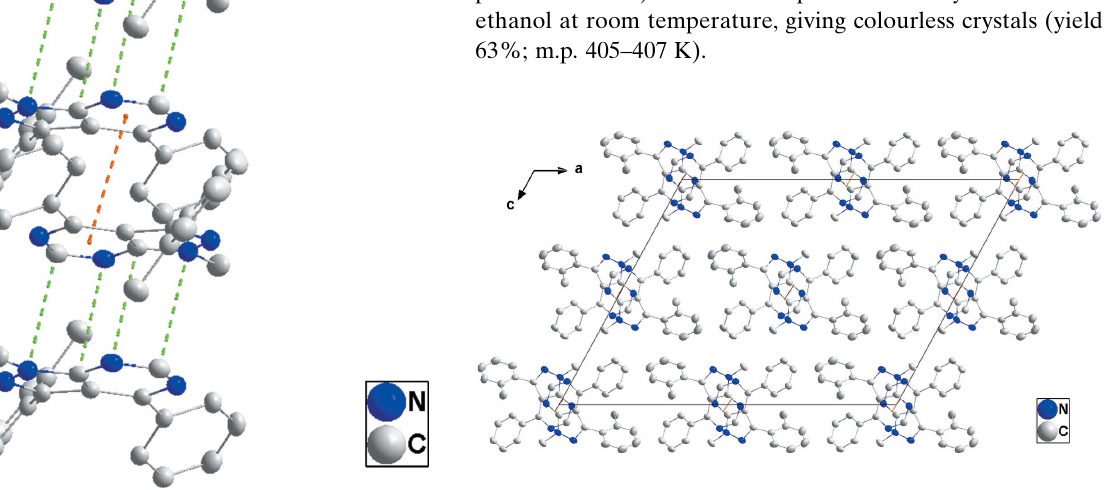
Figure 3 Packing viewed along the b -axis direction, with the (cid:2) -stacking inter- actions shown as orange dashed lines. H atoms have been omitted for clarity.